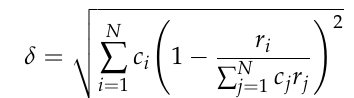
Table 2. The atomic size mismatch ( δ ) of Nb x -CoCrFeMnNi HEAFs with different Nb concentrations. Nb Concentration (at.%)